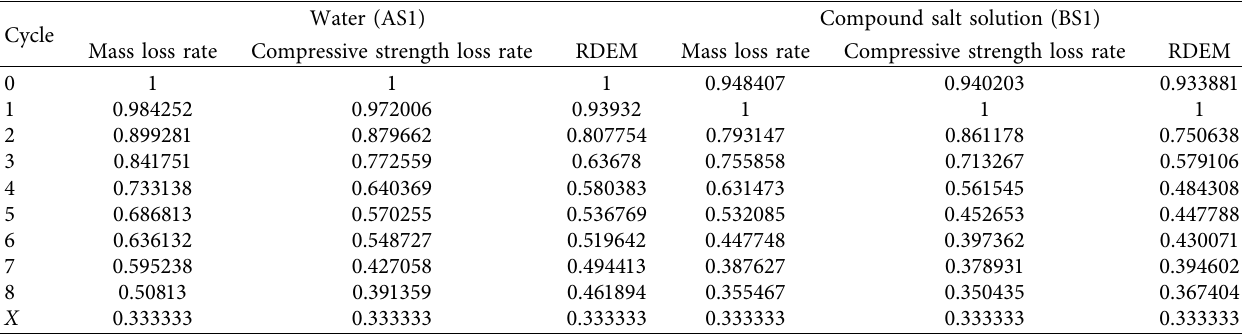
Table 4: Correlation coefficients of evaluation index in group S 1 after adding the X th